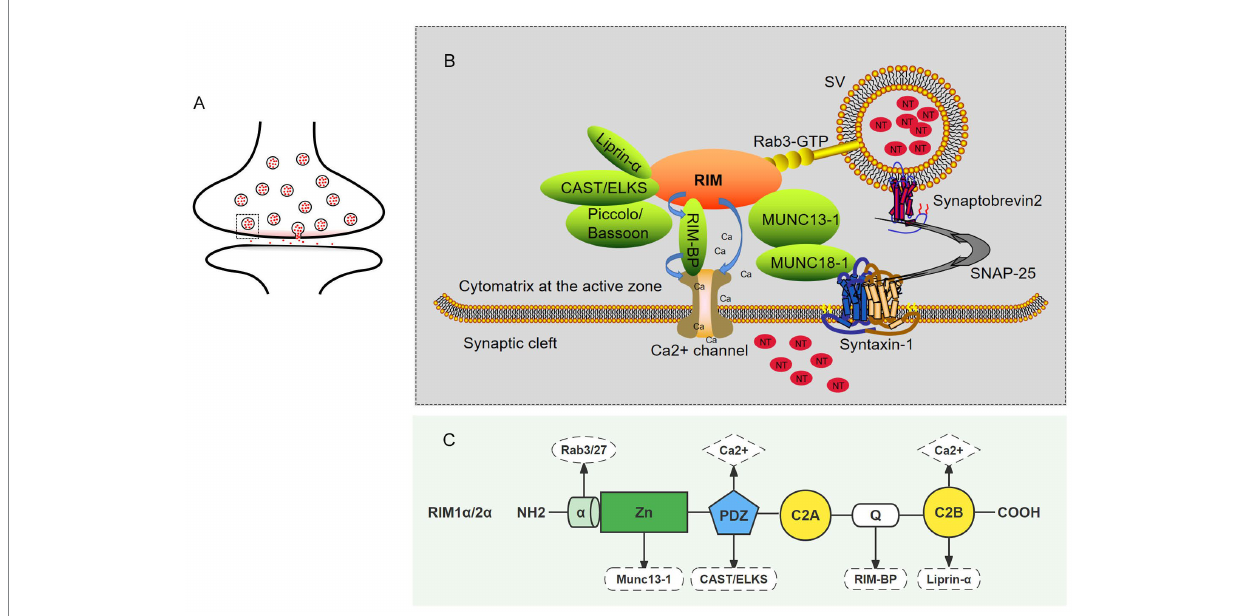
FIGURE 2 The role of RIM proteins in CAZ. (A) Schematic of a synapse. The small circle represents synaptic vesicles, the small red dots contained in the circle represent neurotransmitters, and the gray rectangle (dotted line) represents an active zone. (B) A magnified view of the active zone from the gray rectangle (dotted line) in A. in which interactions between RIM and presynaptic terminal molecules are shown. The upper part is the active zone, the middle part is the presynaptic membrane, and the lower part is the synaptic cleft. The functional elements of the neurotransmitter release mechanism are shown: vesicular protein Rab3 (yellow) protein molecules in the active region (green); the snare proteins VAMP, syntaxin-1, and SNAP-25; the SM proteins Munc18-1 and Munc13-1 as well as calcium channels on the presynaptic membrane; and calcium ions. In the active zone, RIM acts as a scaffold to position important elements at appropriate locations in the active region. (C) The sites of the interactions between the RIM domain and important elements required for neurotransmitter